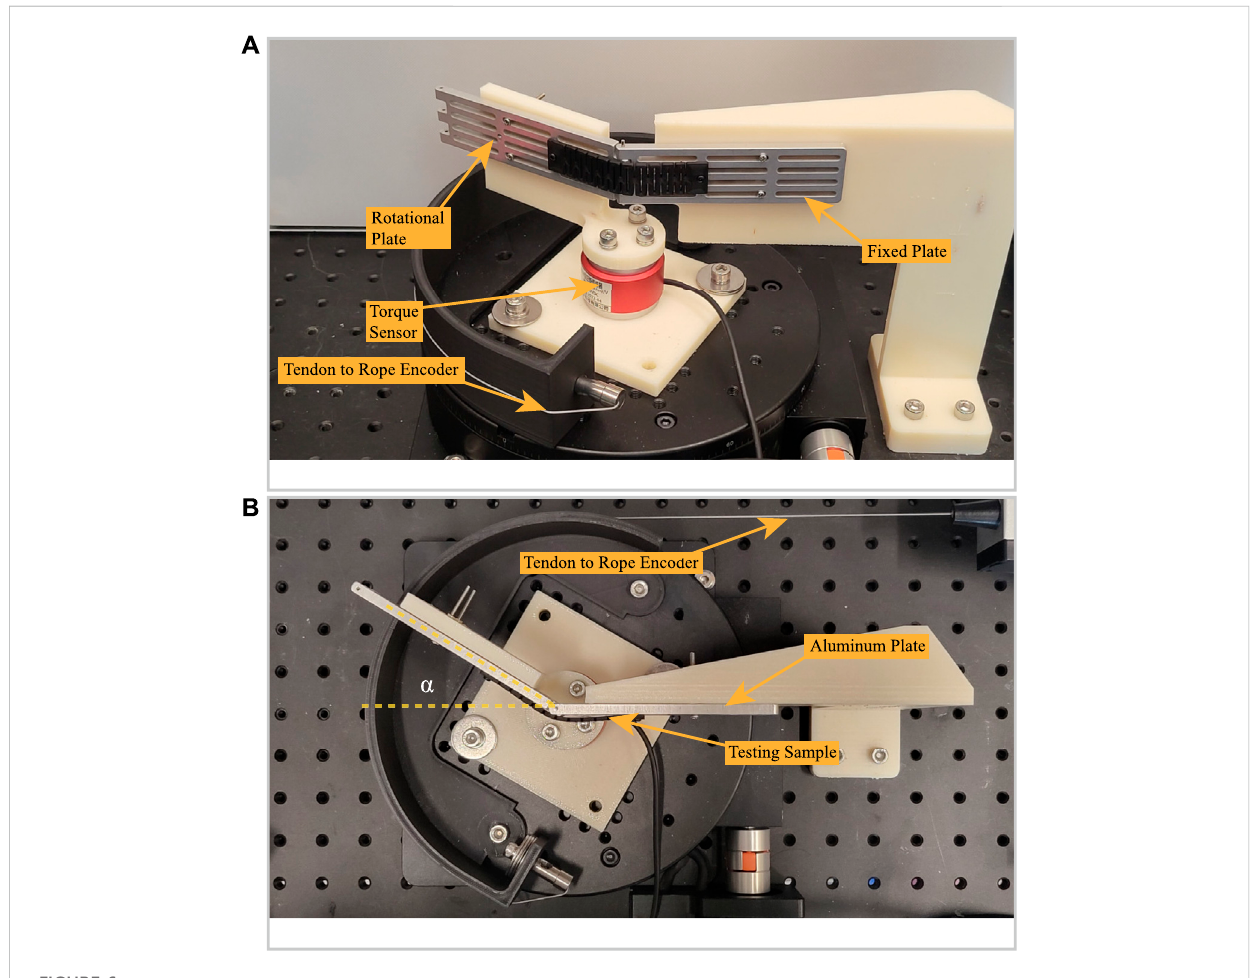
FIGURE 6 Experimentsetupformeasuringstiffnessofexoskeletonhingevertebrate. (A) Sideviewoftheexperimentsetupattheinitialstate. (B) Topviewofthe experiment setup when the bending angle is 30 ° .